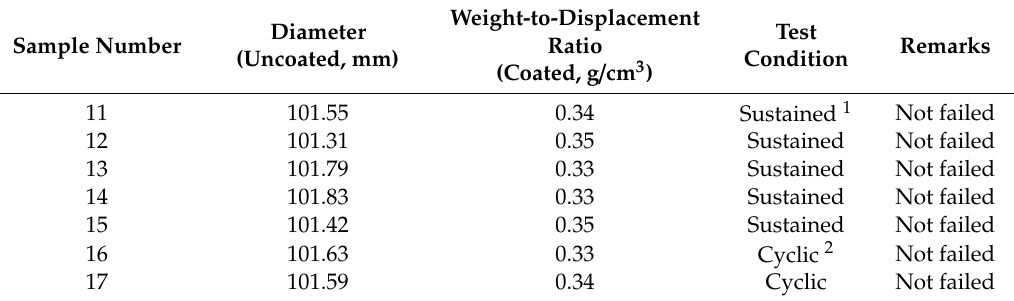
Table 3. Results of sustained and cyclic hydrostatic pressure tests.